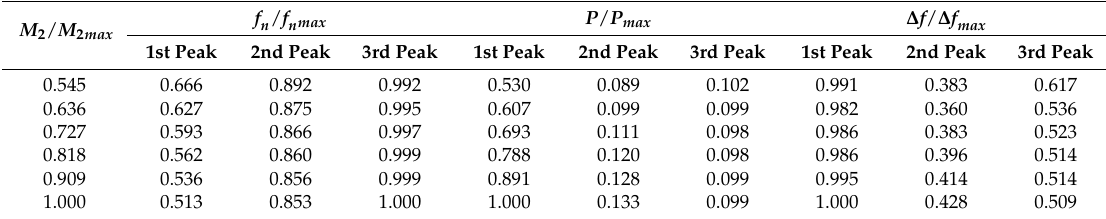
Table 9. Three bimorphs system—the influence of the middle mass, M 2 , normalized values. M 2 / M 2